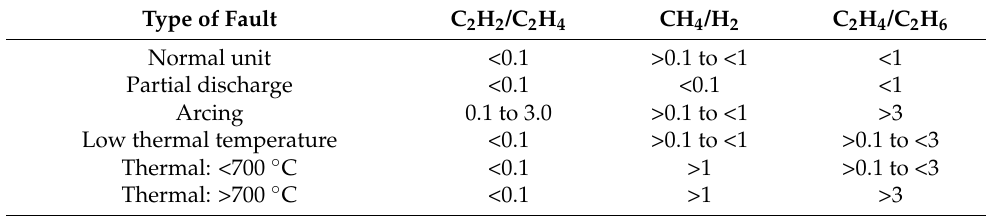
Table 3. Analysis based on Rogers ratios.